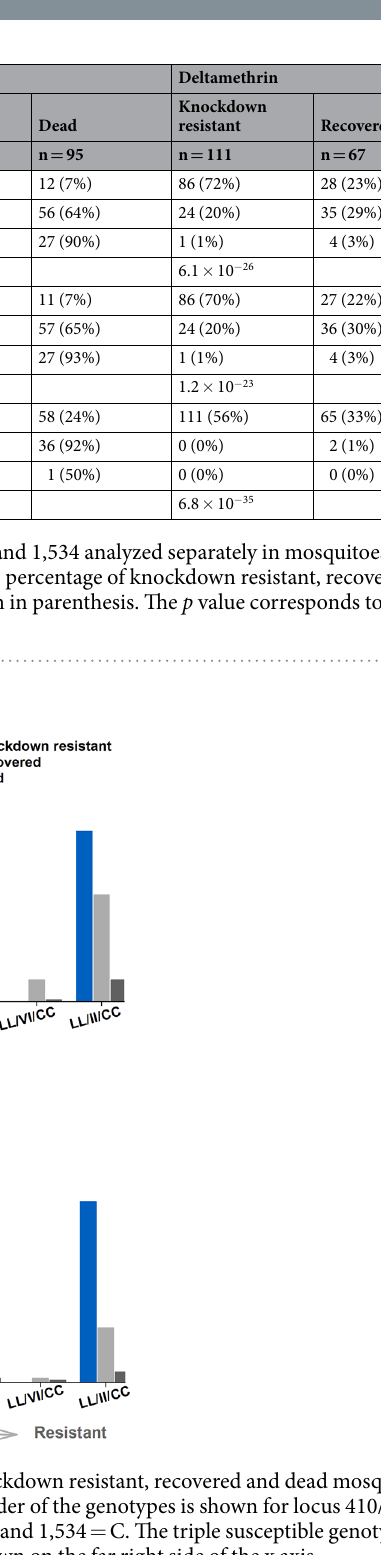
populations, we would expect I1,016 and C1,534 to recombine with L410-C1,534 in future years. However, an alternative scenario is that as in Mexico, L410 is already present at high frequencies in Brazilian collections previ- ously genotyped with I1,016-C1,534 but simply has not yet been detected. The selection of the triple homozygote resistant genotypes detected in our data suggests higher fitness of this genotype in the presence of pyrethroids. The role of L410 and C1,534 in conferring pyrethroid resistance was determined in Haddi et al . 2016 13 . L410 alone or in combination with C1,534 confers high levels of resistance,